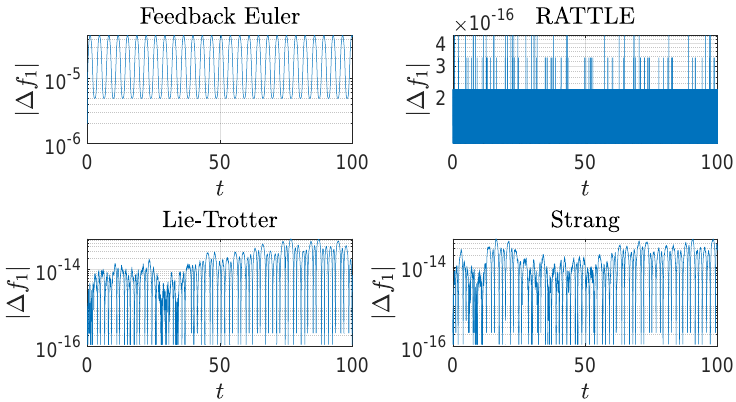
Figure 1. The trajectories of the position q ( t ) = ( q 1 ( t ) , q 2 ( t ) , q 3 ( t )) , 0 ≤ t ≤ 100, of the spherical pendulum generated by four different methods with step size h = 10 − 3 : a feedback integrator with the Euler scheme, the RATTLE method, the Lie–Trotter splitting method, and the Strang splitting method.